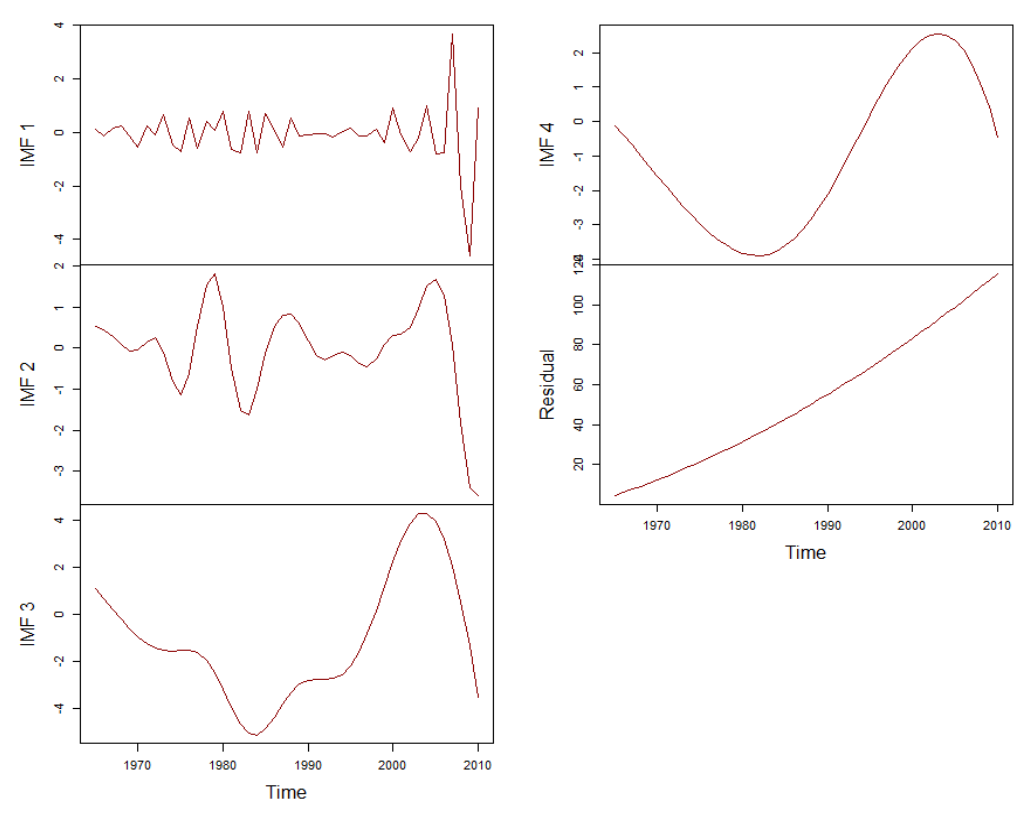
Figure 3. Decomposition results for primary energy consumption via EEMD.